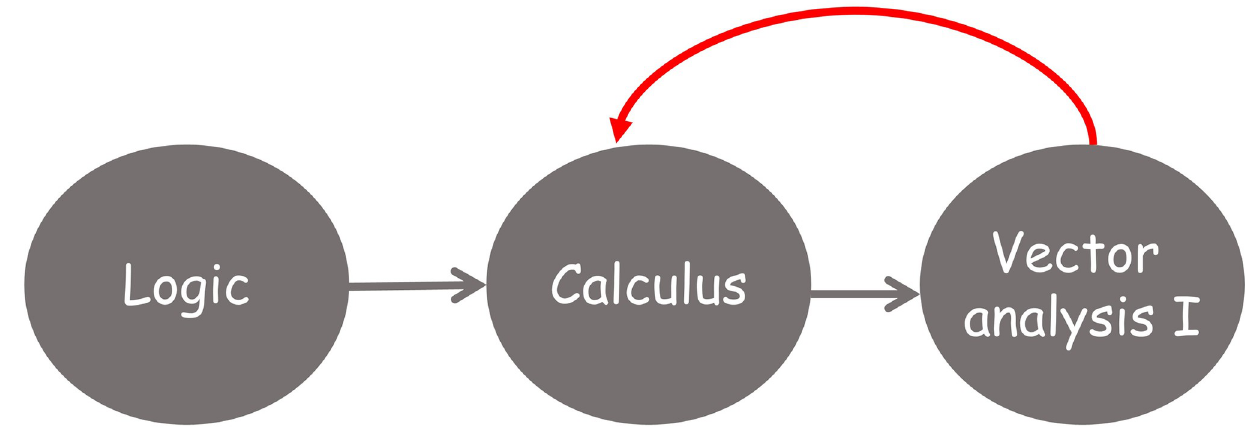
Fig 6. Example of non-desirable arcs.